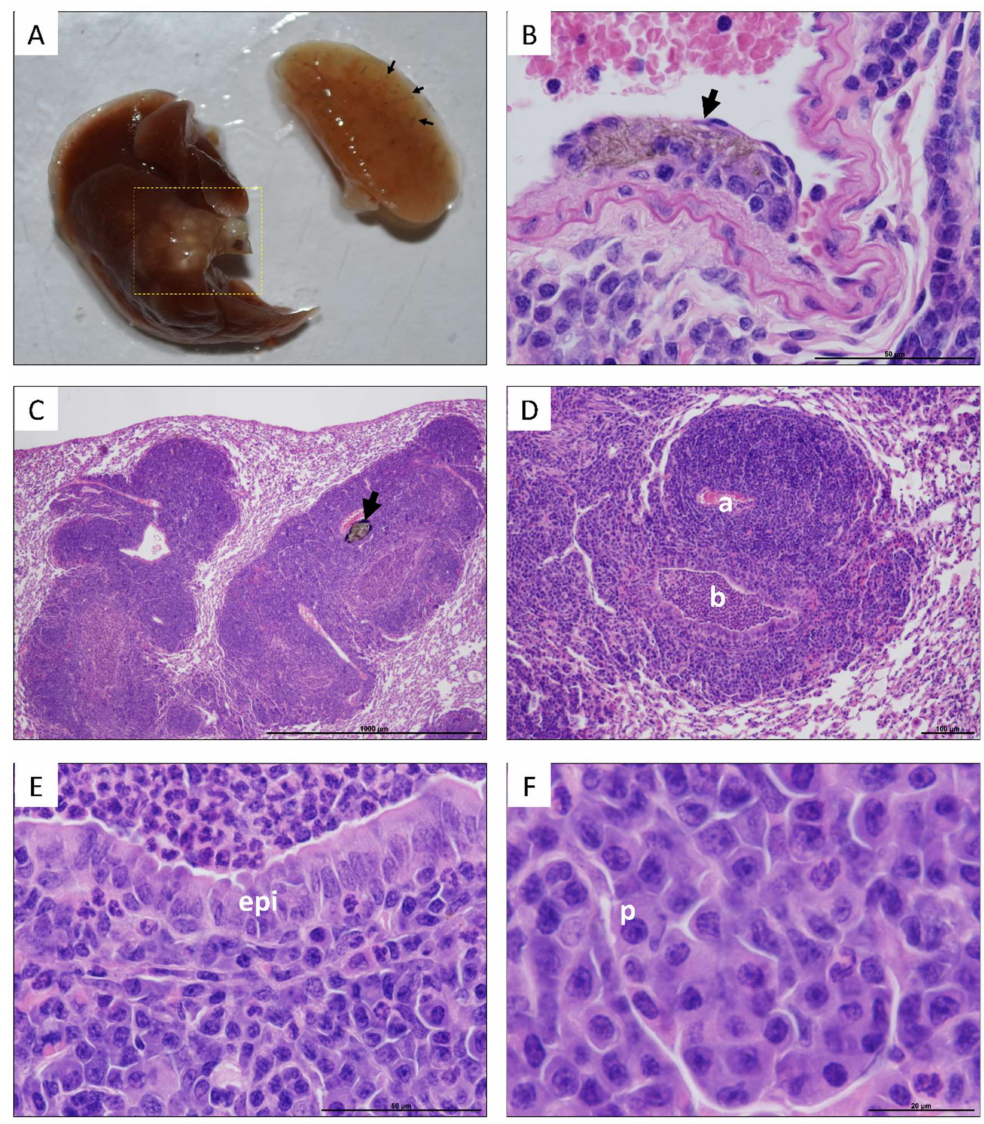
Figure 3. Macroscopic and microscopic lesions observed in lungs of mice exposed to UP-CNTs 60 days after exposure. A , Macroscopic aspect of lungs from a mouse exposed to UP-CNTs; the black arrows indicate the accumulation of nanoparticles mainly in the peripheral areas. The dotted line on the left lung indicates a tumor growth lesion. Microphotographs show: B , UP-CNTs trapped under endothelium (arrow) found in the right lung (magnification 60 × ); C , general aspect of lesions detected in the left lung, the arrow indicates the accumulation of UP-CNTs (arrow, magnification 4X); D , malignant lymphoproliferative lesion of peribronchial and perivascular localization, artery ( a ) is surrounded by several layers of large lymphocytes, bronchiole ( b ) looks obstructed by neutrophils (magnification 10 × ); E , the bronchiole epithelium ( epi ) in contact with neutrophils inside luminal space (magnification 60 × ), and; F , an area with large lymphocytes with abnormal nuclei (plasmocyte, p ) (magnification 100 ×